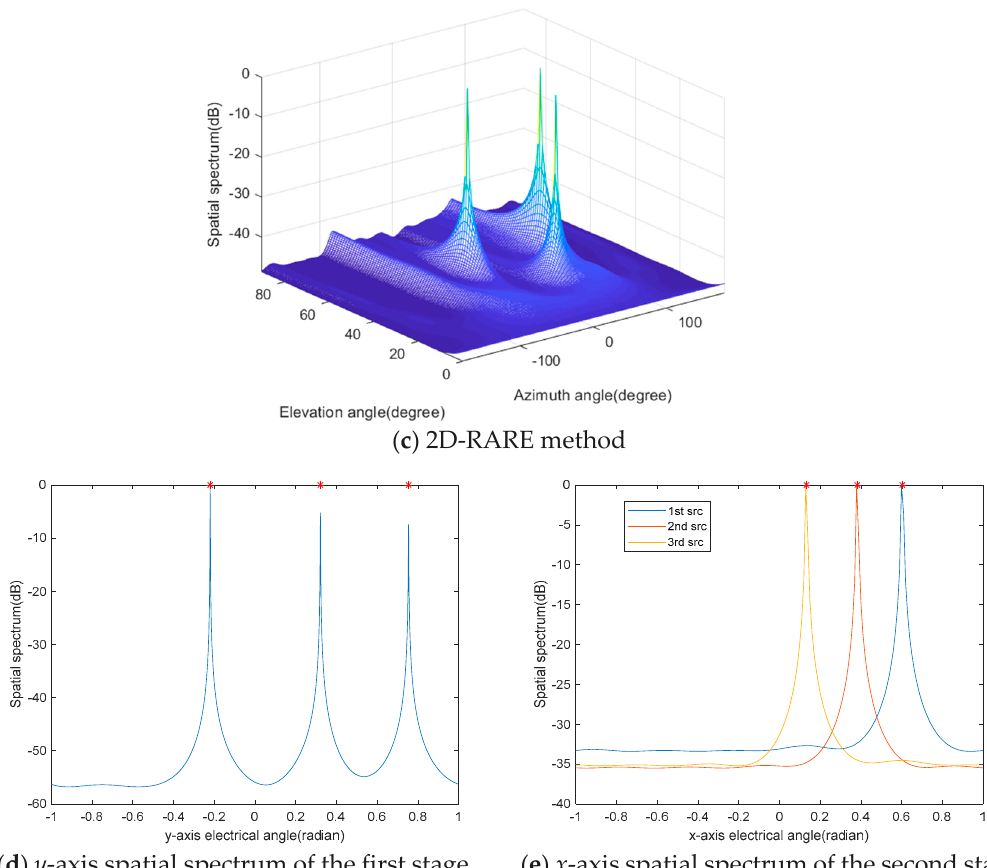
Figure 2. The spatial spectra of ( a ) Two-dimensional multiple signal classification (2D-MUSIC), ( b ) the auxiliary sensor-based method (AUX), ( c ) the 2D rank reduction-based method (2D-RARE) and ( d ) the first stage and ( e ) the second stage of the proposed method.